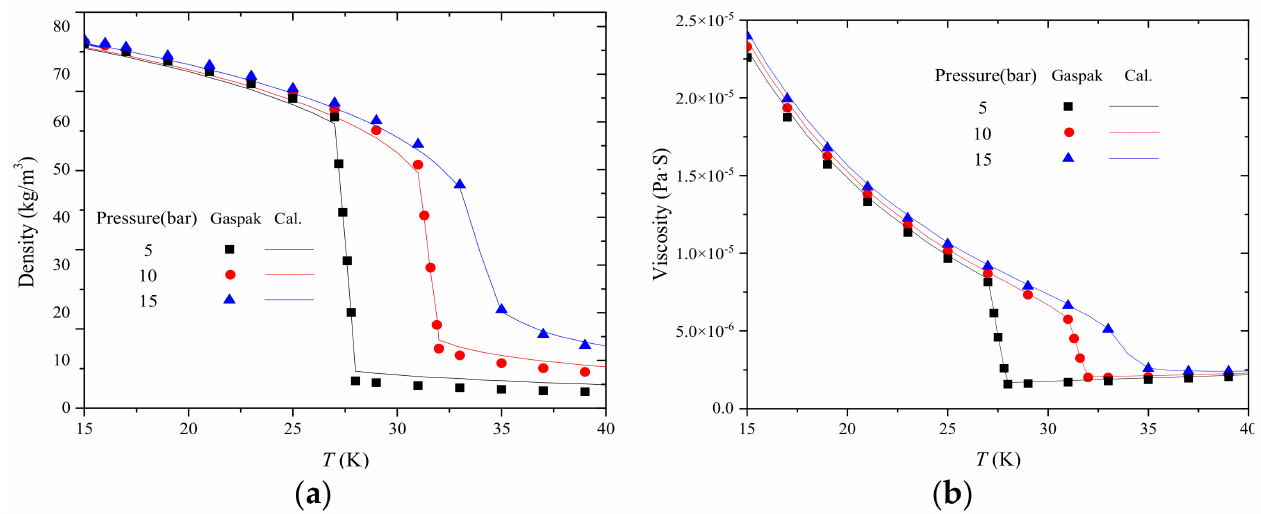
Figure 5. Comparison of simulation results with GSPAK data of thermophysical properties: ( a ) Density; ( b )